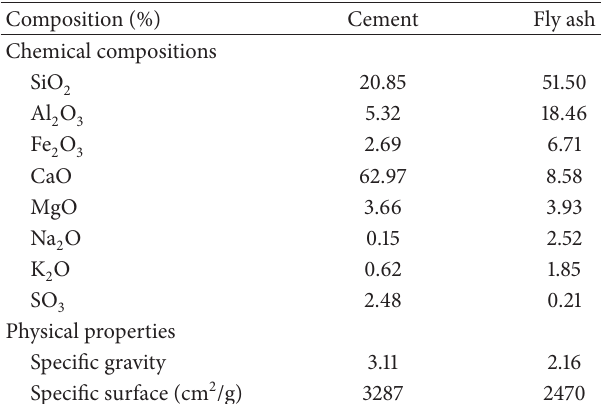
Table 1: Properties of cement and fly